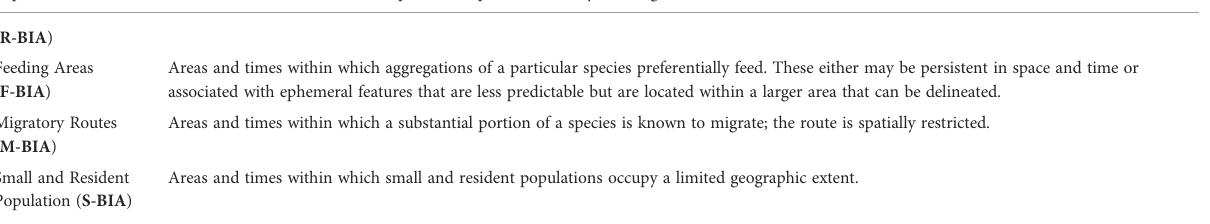
TABLE 1 De fi nitions of BIA